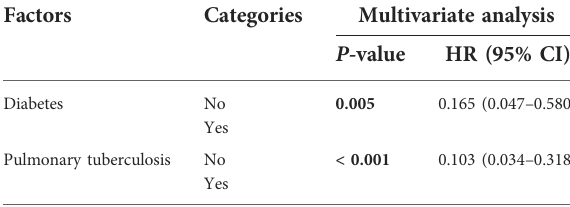
TABLE 6 Multivariate logistic analyses of risk factors for TS after PVP/PKP.